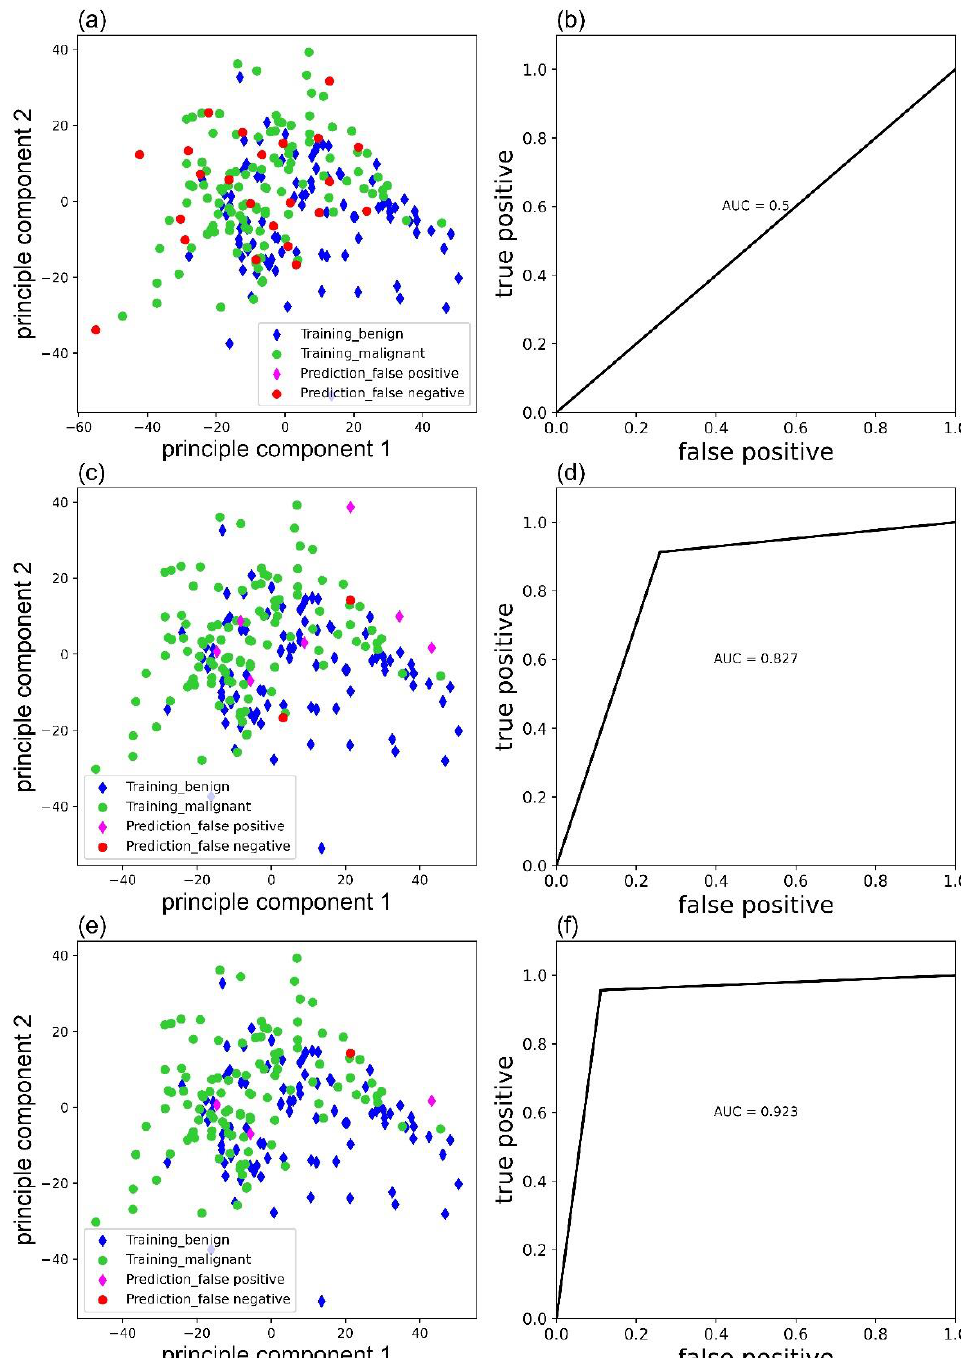
Figure 5. False predictions of the MLP classifier trained with ‘sgd’ ( a ), ‘adam’ ( c ), and ‘lbfgs’ ( e ) as solver and corresponding ROC curves ( b ), ( d ) and ( f ).